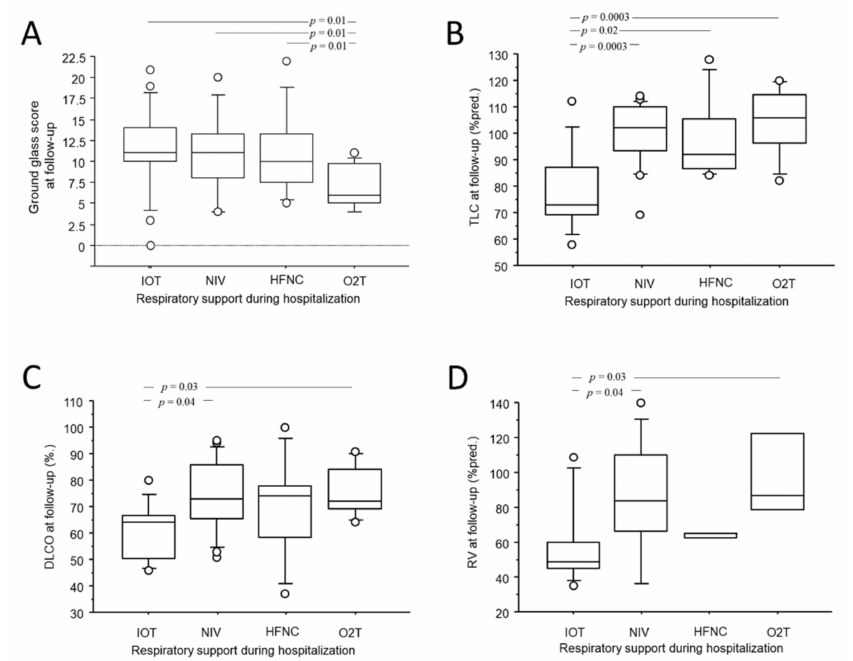
Figure 3. Box-plot comparison of GG at CT FU ( A ), the TLC ( B ), the DLCO ( C ), the RV ( D ) at follow-up with respiratory support needed during hospitalization. Solid line represents the median; bottom and top of the boxes are the 25th and 75th percentiles; brackets correspond to the 10th and the 90th